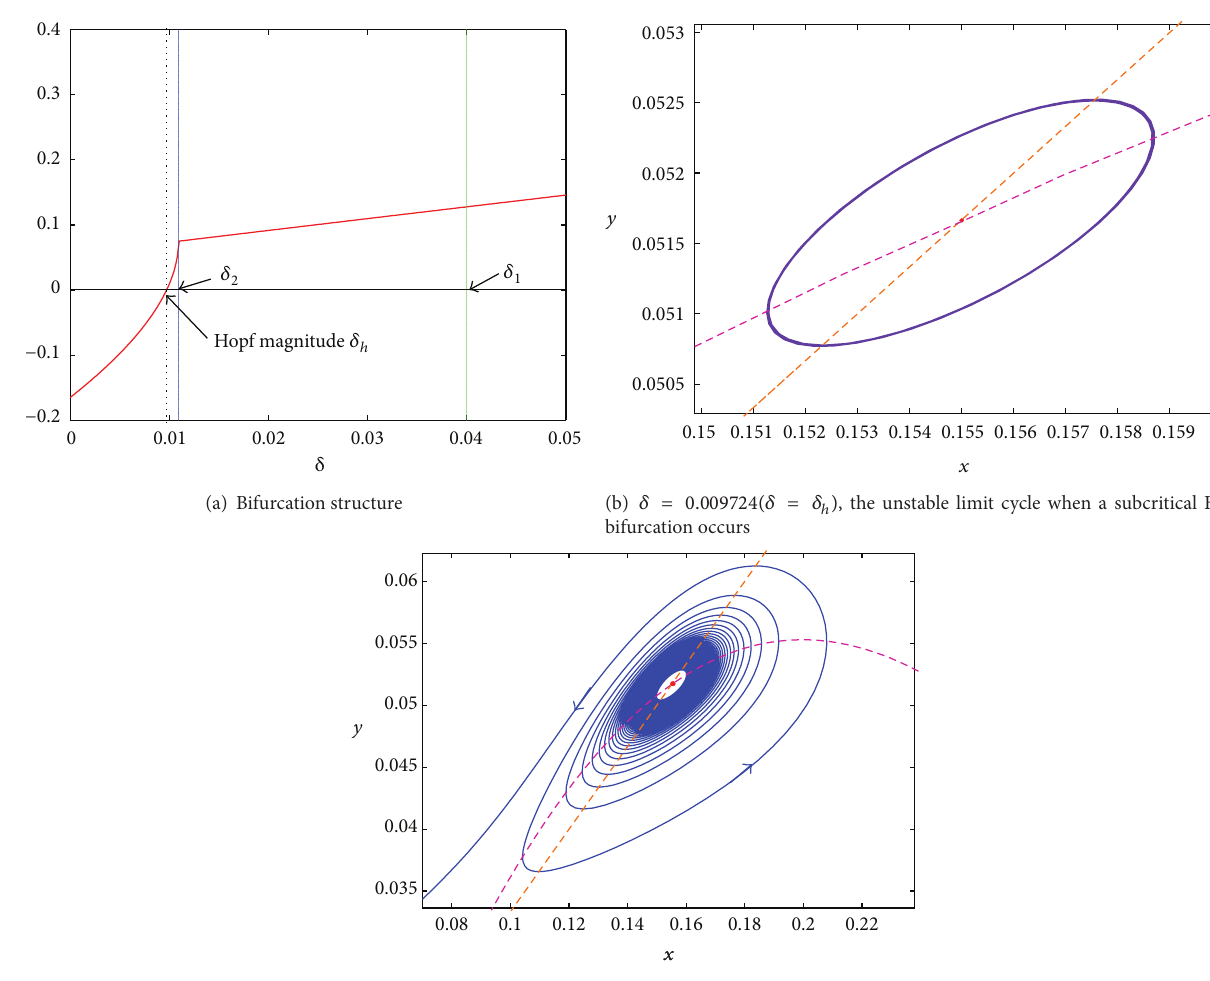
Figure 3: Bifurcation structure of 𝐸 2∗ for Hopf bifurcation and phase portraits of system (7) for 𝑔 = 1.44 , 𝛼 = 0.8 , 𝛼 1 = 0.4 , and 𝛽 = 0.3 .